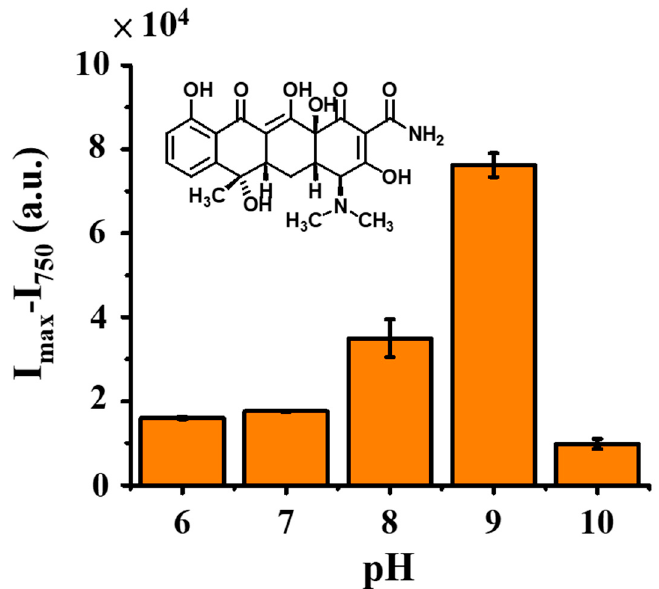
Figure 3. Examination of pH effects. Bar graphs showing the summarized results obtained from three replicates. Inset shows the chemical structure of TC. The sample (0.3 mL) containing TC (0.1 µ M) was vortex-mixed with aqueous zinc chloride (1.49 mM) prepared in different pH conditions for 10 min, followed by the investigation by fluorescence spectroscopy.